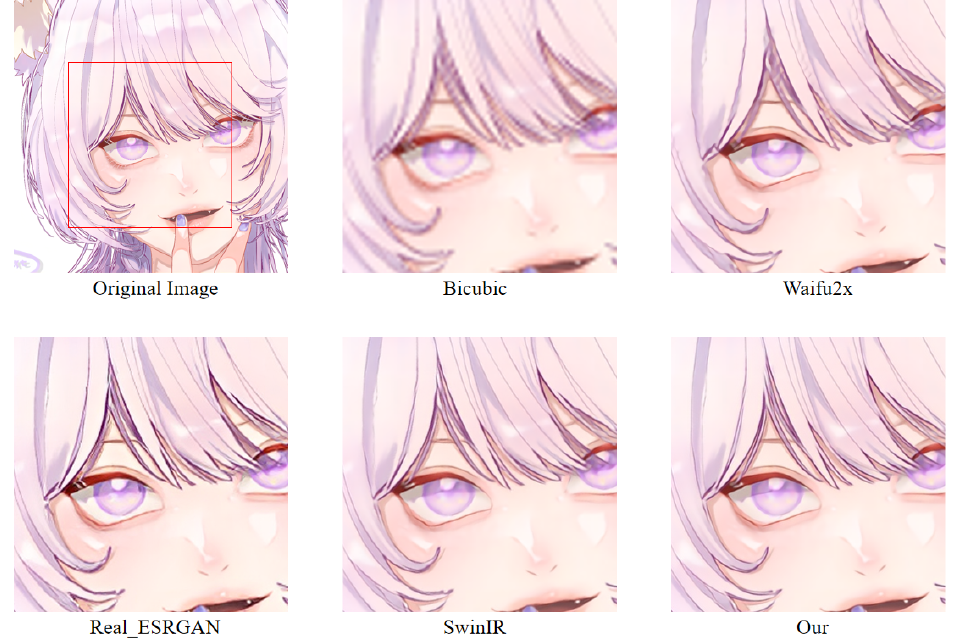
Figure 24. A result of an example image from the Animeface180 test dataset for different super- resolution methods. Facial detail comparison at 8 × super-resolution